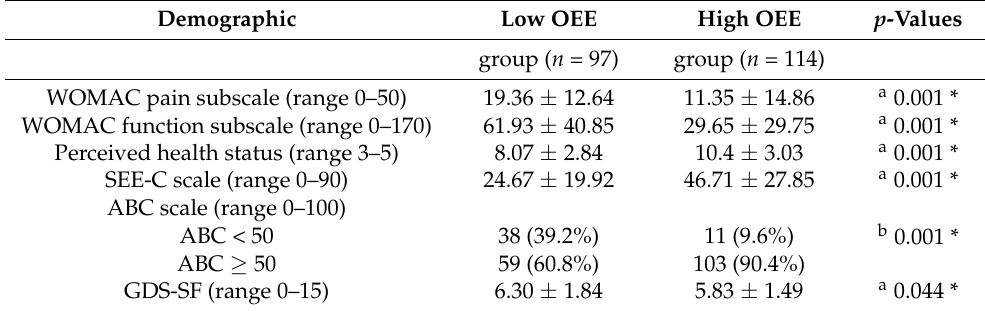
Table 3. Difference Between Lower and Higher Outcome Expectation Groups. Demographic Low OEE High